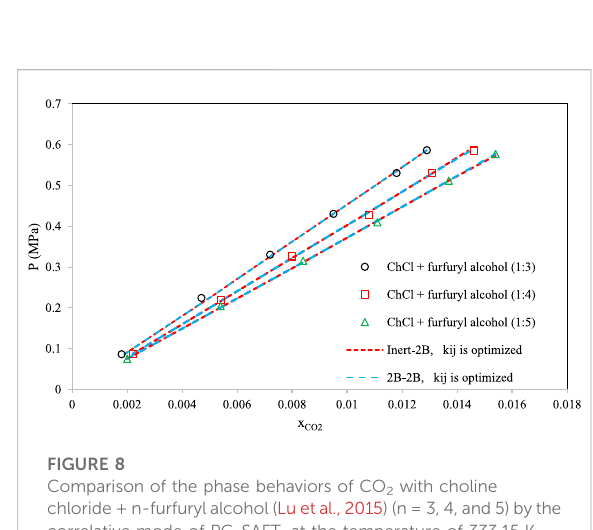
FIGURE 8 Comparison of the phase behaviors of CO 2 with